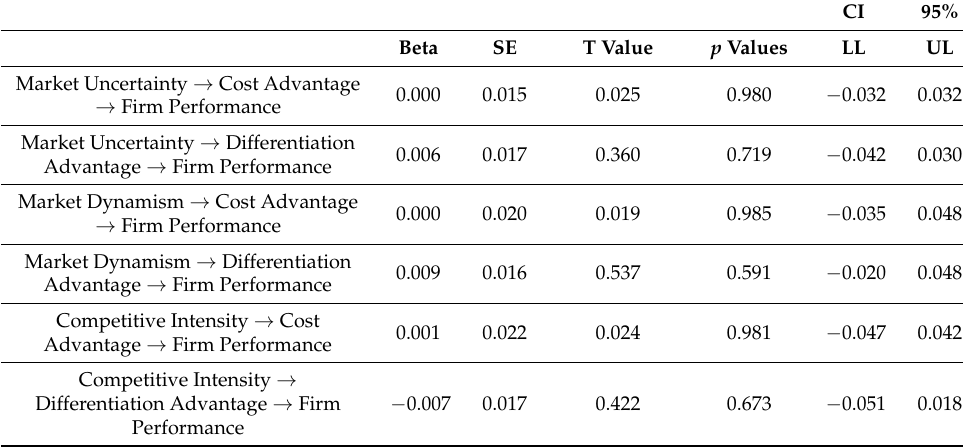
Table 6. Test of indirect effects using